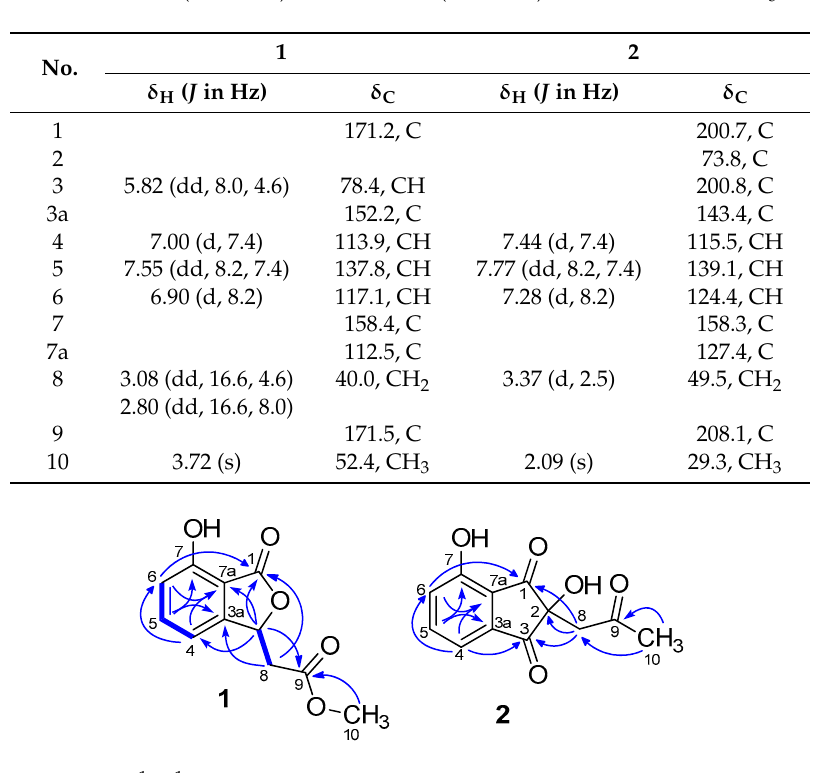
Figure 2. Key 1 H- 1 H COSY ( ▬ ) and HMBC ( ) correlations for compounds 1 , 2 .